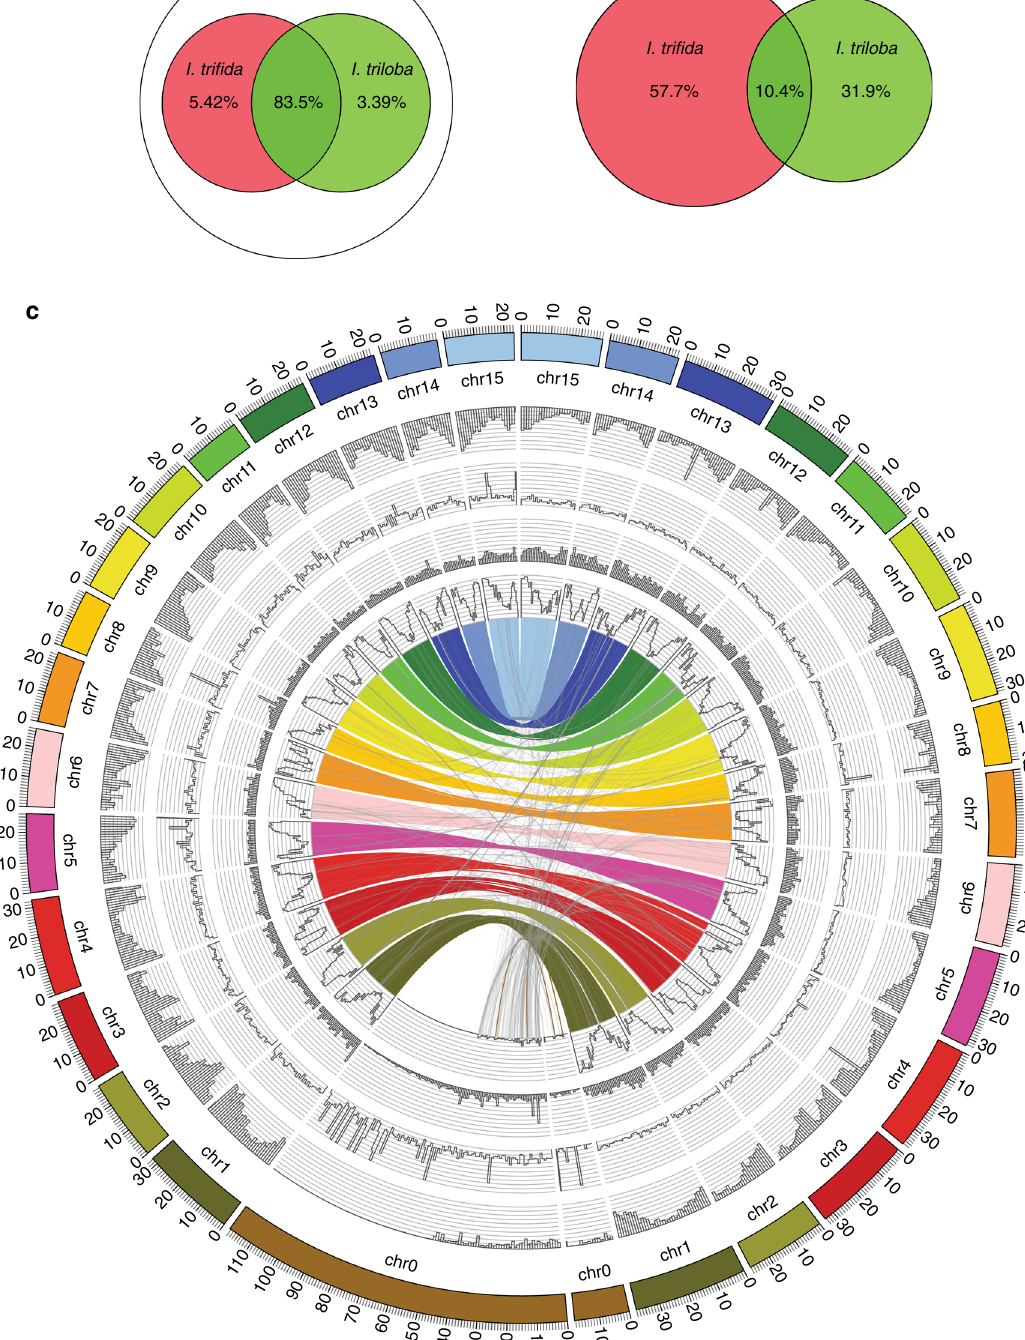
Fig. 3 Comparative genomic analysis of hexaploid sweetpotato and two wild relatives. a Percentages of the mapped and unmapped 10× Genomics linked reads of hexaploid sweetpotato cultivar “ Tanzania ” to the I. tri fi da and I. triloba genome assemblies. b Percentages of 10× Genomics reads with better alignments when mapped to one genome assembly compared to the other. c Comparison of the hexaploid sweetpotato molecules with the two diploid assemblies. The outermost circle displays ideograms of the pseudochromosomes of the genome assemblies (in Mb scales). The I. tri fi da genome is on the left and the I. triloba genome is on the right. The second circle displays the normalized depth of coverage by 10× Genomics reads (1 Mb window). The third circle displays the average read depth of coverage of regions speci fi cally homologous to I. tri fi da or I. triloba genomes (1 Mb window). The fourth circle displays the total length of speci fi c regions (1 Mb window size). The fi fth circle displays the percentage of the homologous sequences shared among the hexaploid genome and the two diploid genomes (1 Mb window size). The innermost circle displays homologies among the hexaploid and two diploid